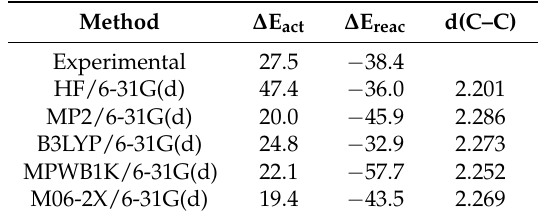
Table 1. Activation and reaction energies a , in kcal·mol − 1 , and C–C distances of the two forming single bonds, in Angstroms, at TS1 , obtained using different computational levels.